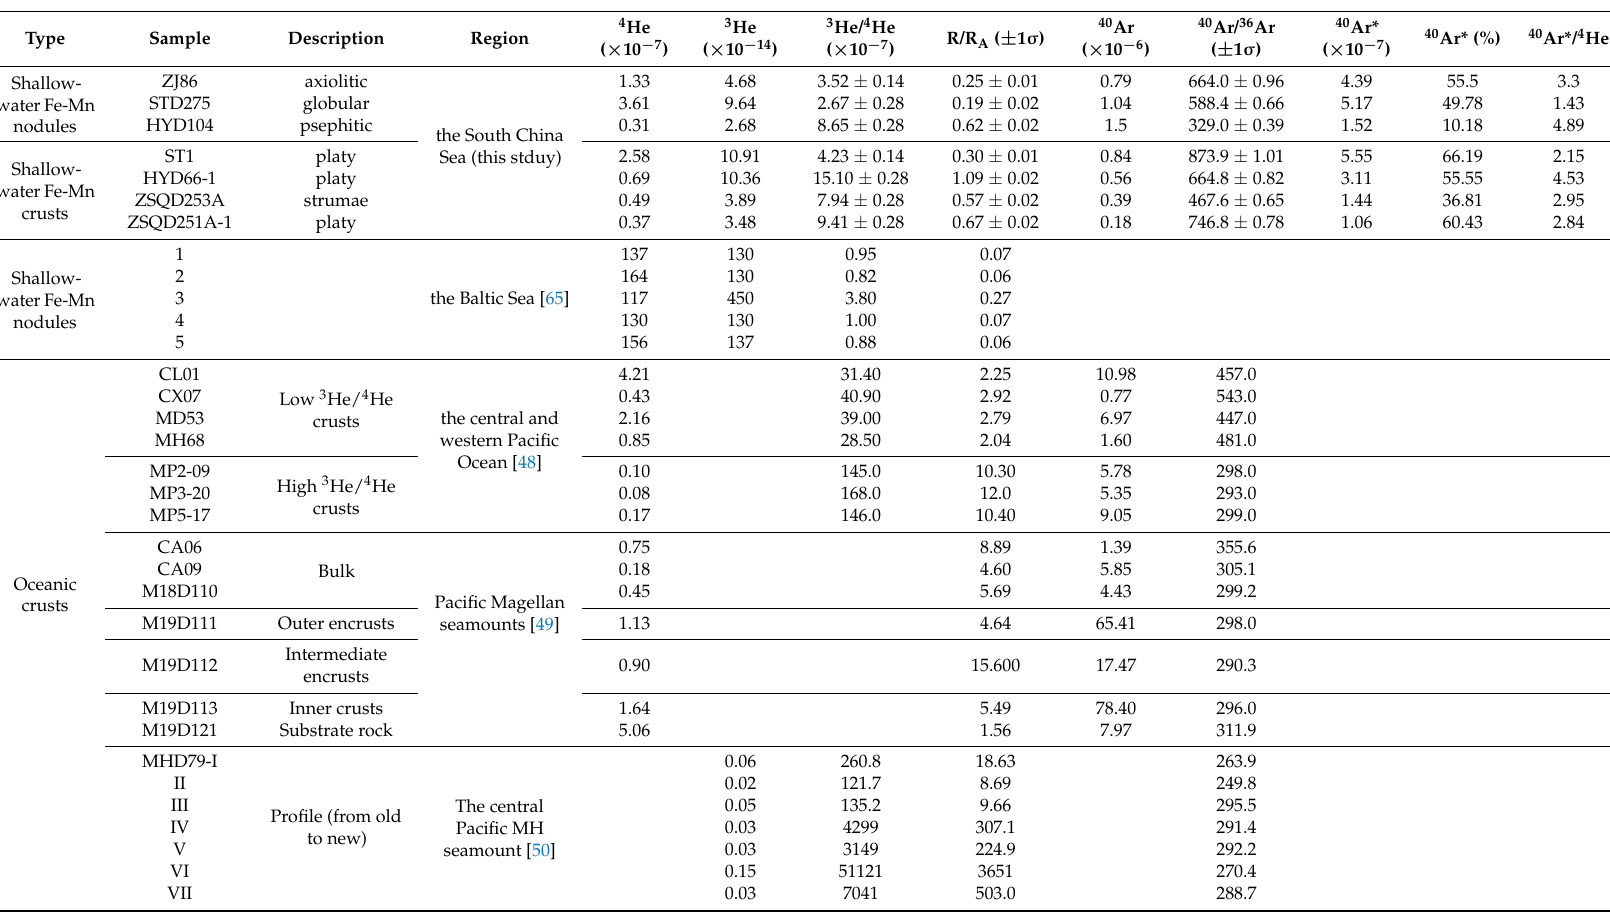
Table 2. Helium and Ar isotope compositions (cm 3 · STP · g − 1 ) and ratios of the Fe-Mn crusts and nodules from this study and other